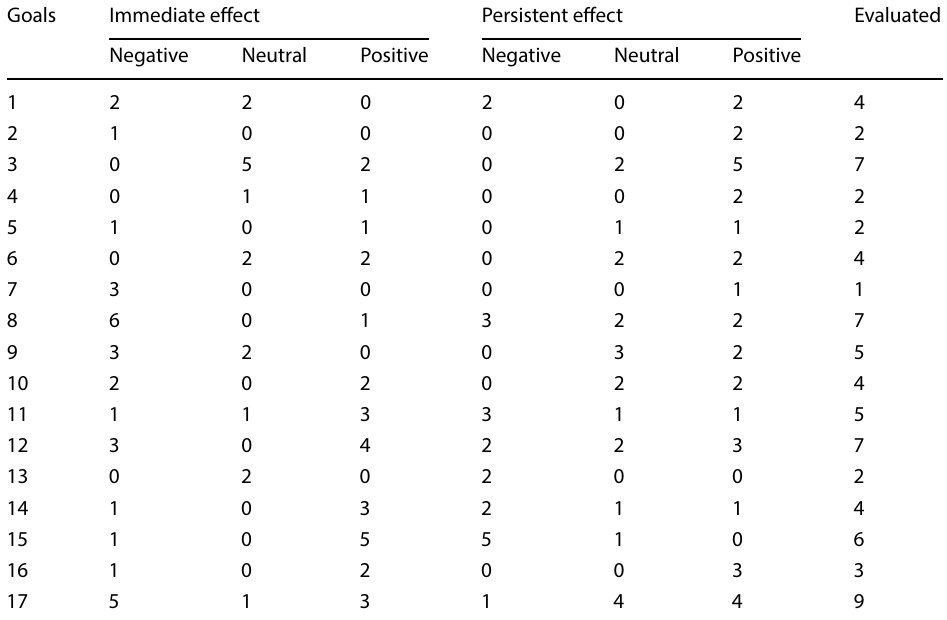
Table 1 Scoring of global lockdown effects on SDG targets (the scores of immediate and persistent effects of global lockdown on each